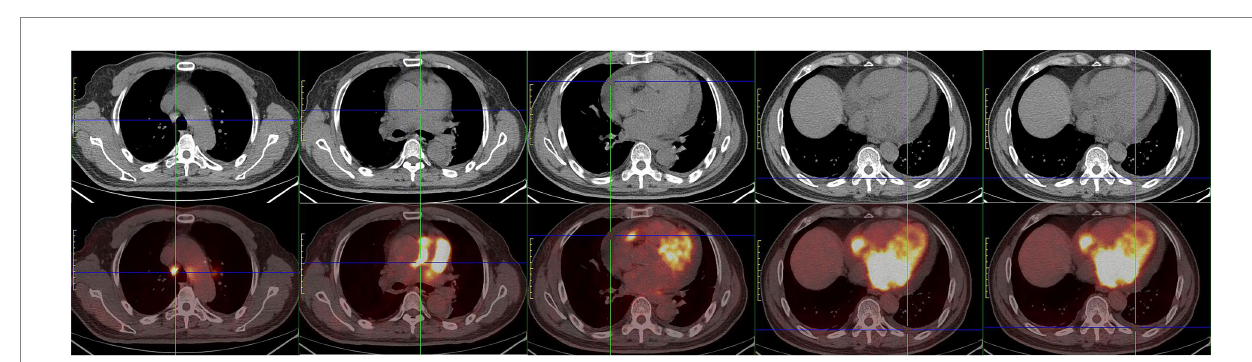
FIGURE 3 18 F-fluorodeoxyglucose (FDG) positron emission tomography computed tomography (PET-CT) indicated multiple soft tissue nodules/masses with high FDG uptake in the pericardial cavity and a number of lymph nodes with high FDG uptake in the